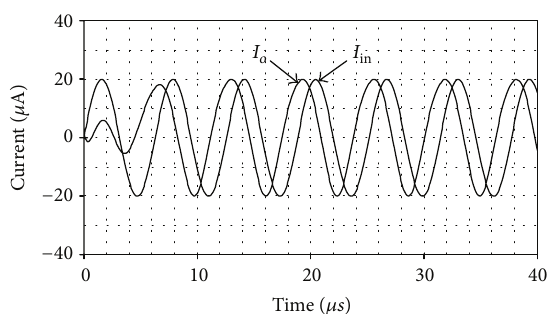
Figure 10: Time-domain responses of the realized third-order all- pass circuit in Figure 6(b).